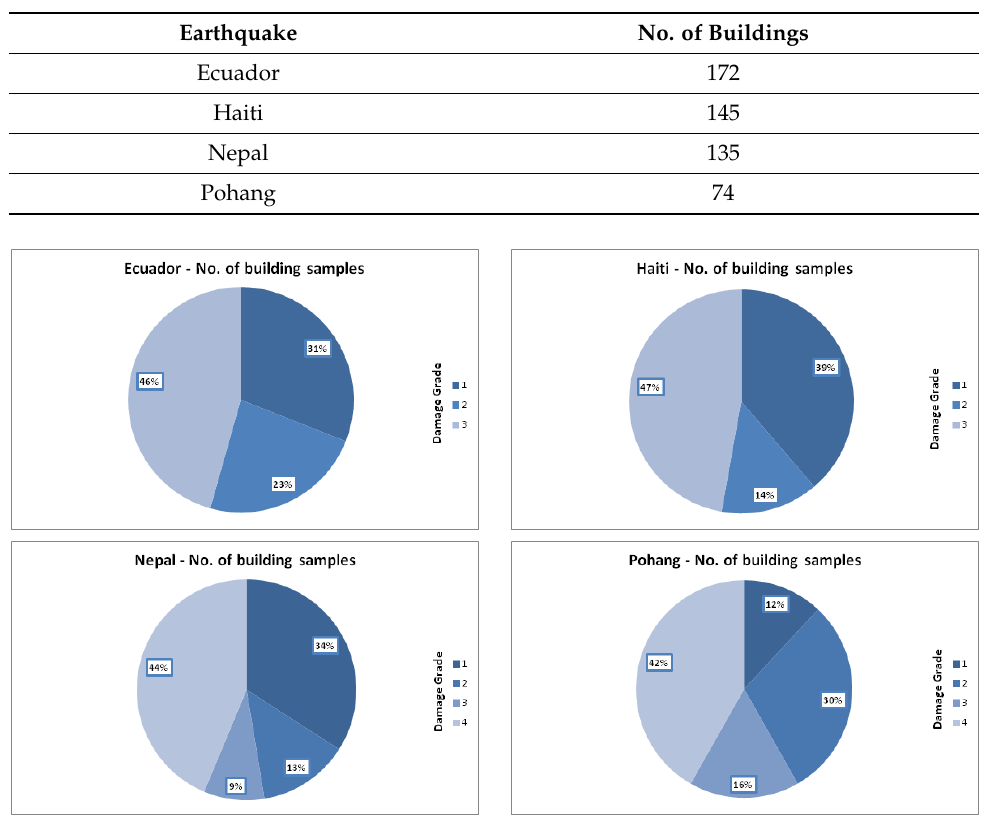
Table 2. Number of buildings for each earthquake’s dataset.